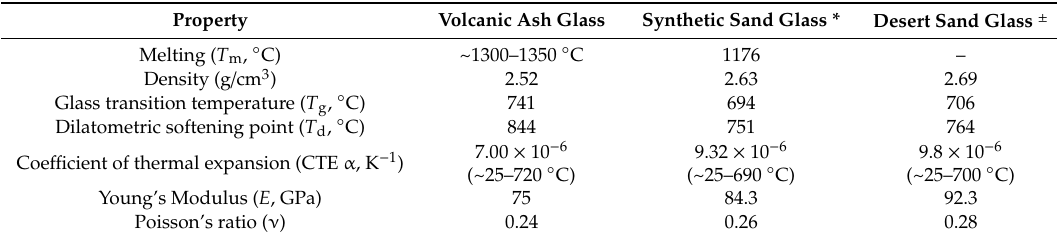
Coe ffi cient of thermal expansion (CTE α , K − 1